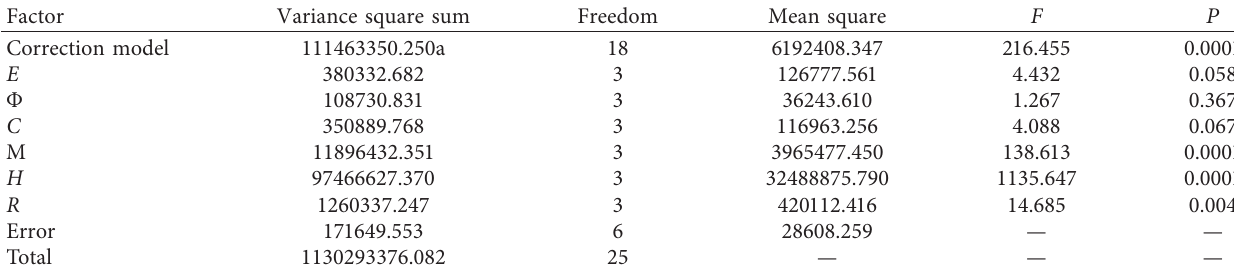
Table 4: Variance analysis for peak